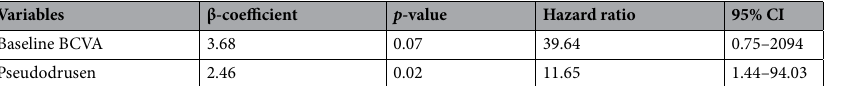
Variables β-coefficient p